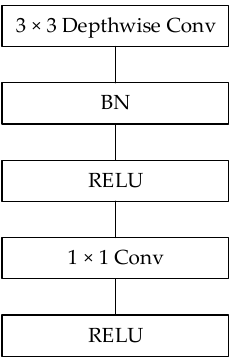
Figure 7. Depthwise separable convolution block structure.